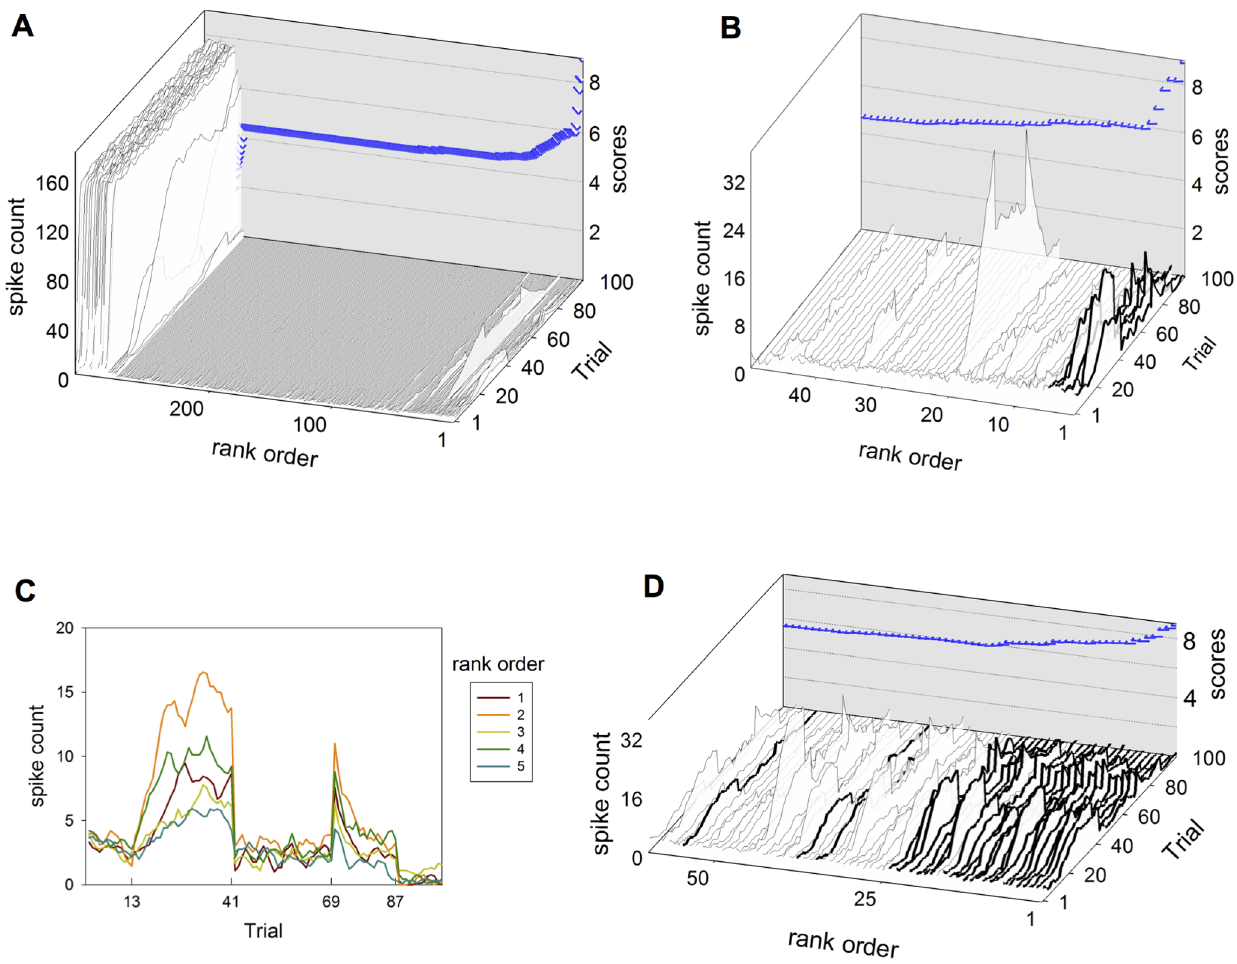
Figure 9. Exhaustive search of plasticity coefficients for the STDE model, seeking D1-MSN spike count profiles for operant learning (see Figure 1). (A) The best scoring 300 (out of 625) D1-MSN activity profiles from a broad search across the entire parameter range. (B) The top 50 ranked profiles from (A); note the much smaller range of spike counts on the vertical axis compared with (A). (C) The top five profiles from this coarse- grained search (heavy lines in (B)) used to define a more focused, fine-grained search. (D) The top-scoring 60 D1 MSNs from the focused search. The best 26 were deemed good matches by visual inspection (shown in heavy lines) and their coefficients constituted the discovered set.